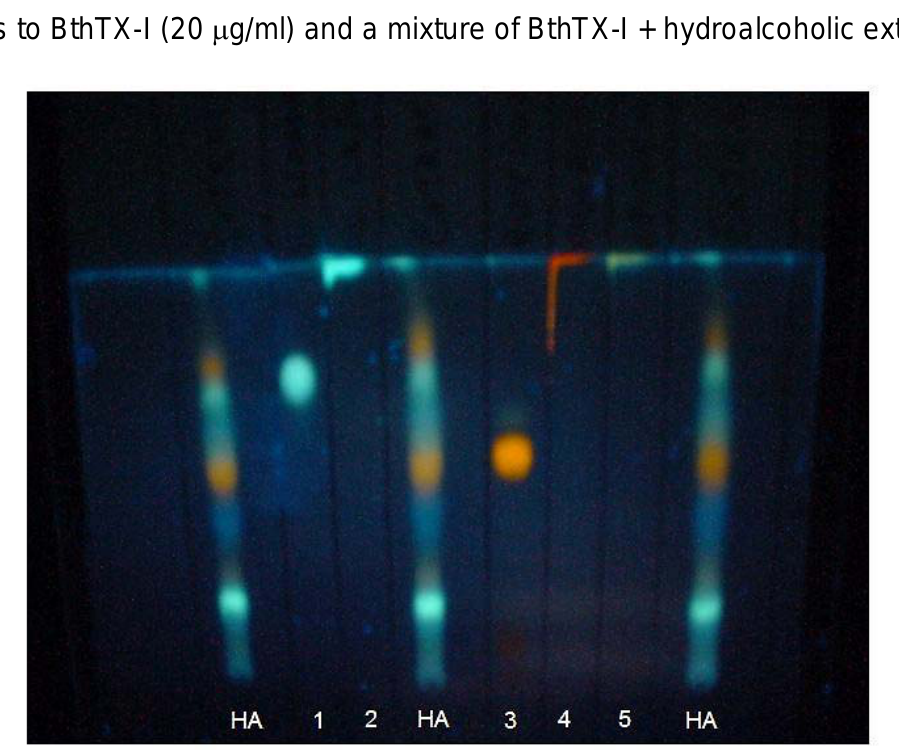
Figure 1: Thin-layer chromatography. Hydroalcoholic (HA) extract of leaves from Casearia sylvestris Sw. Solvent system: ethyl acetate : formic acid : glacial acetic acid : water (100:11:11:26, v/v). Spot detection: NP (diphenylboric acid 2-aminoethyl ester) and PEG (polyethylene glycol 4000). Phytochemical standards: 1 – chlorogenic acid, 2 –caffeic acid, 3 – rutin, 4 – quercetin, 5 – apigenin. Note the similarity between the Rf values of the constituents present in the extract and those of rutin (3, orange) and chlorogenic acid (5,